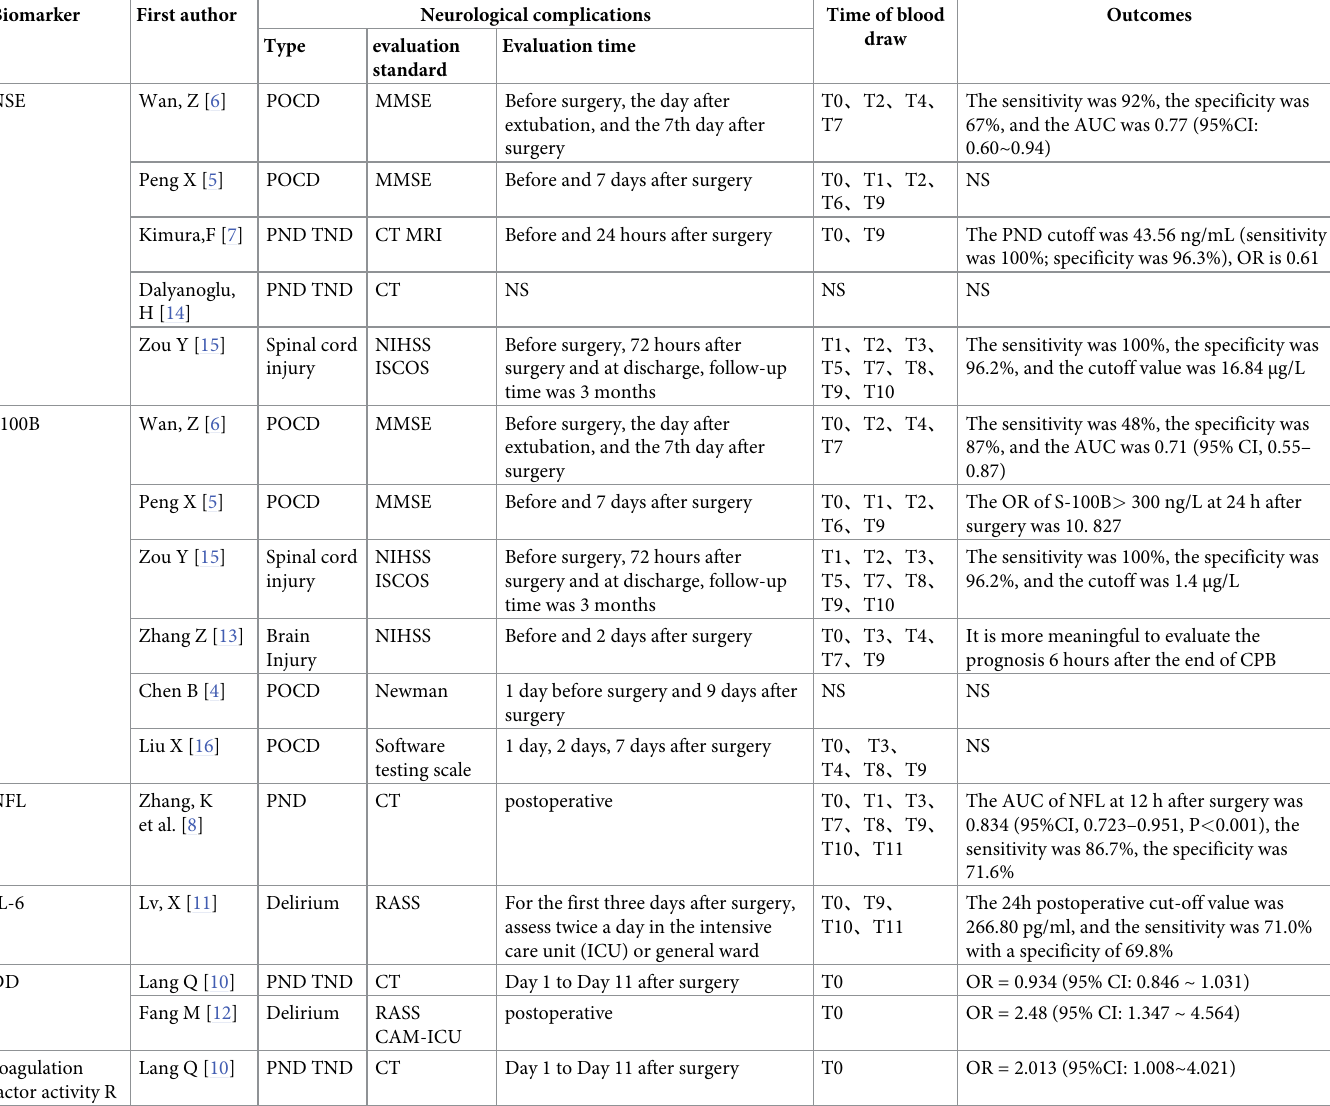
Table 2. Cut-off value, sensitivity, specificity, AUC and other observation indexes for NSE, S100B, NFL, IL-6, DD and coagulation factor activity R.